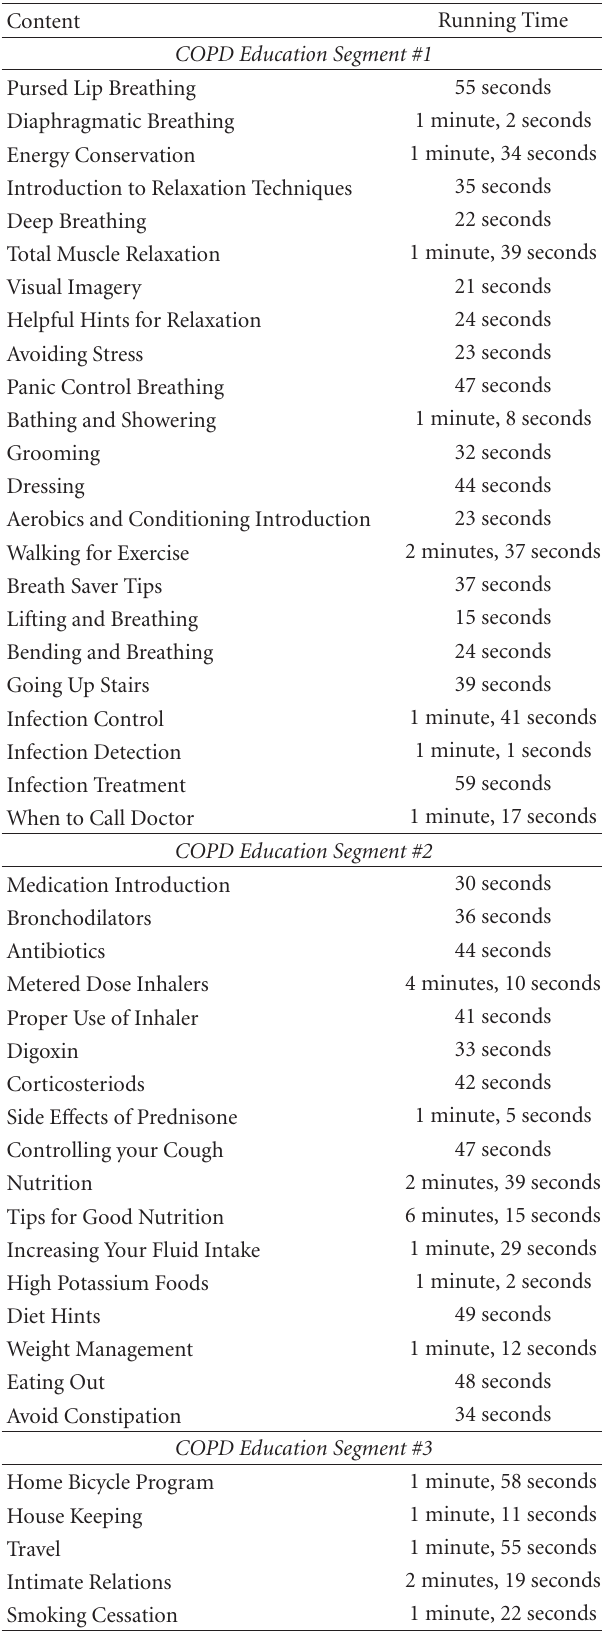
Table 3: Content covered within 3 RVision DVD